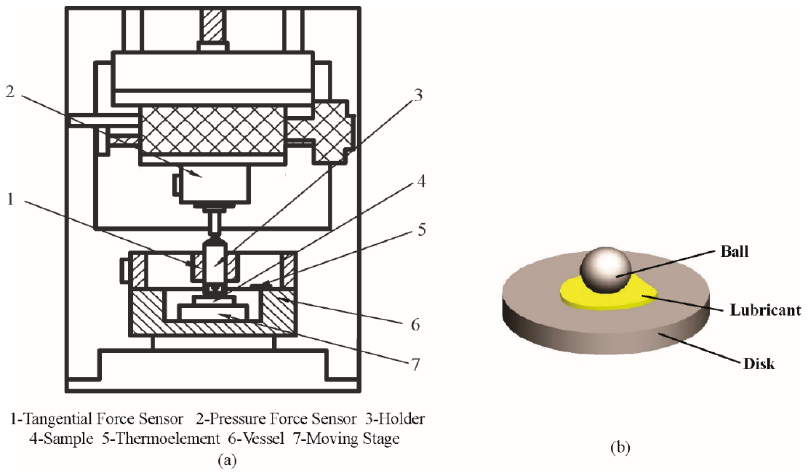
Figure 4. Schematic of ( a ) testing system and ( b ) ball ‐ on ‐ disk configuration.